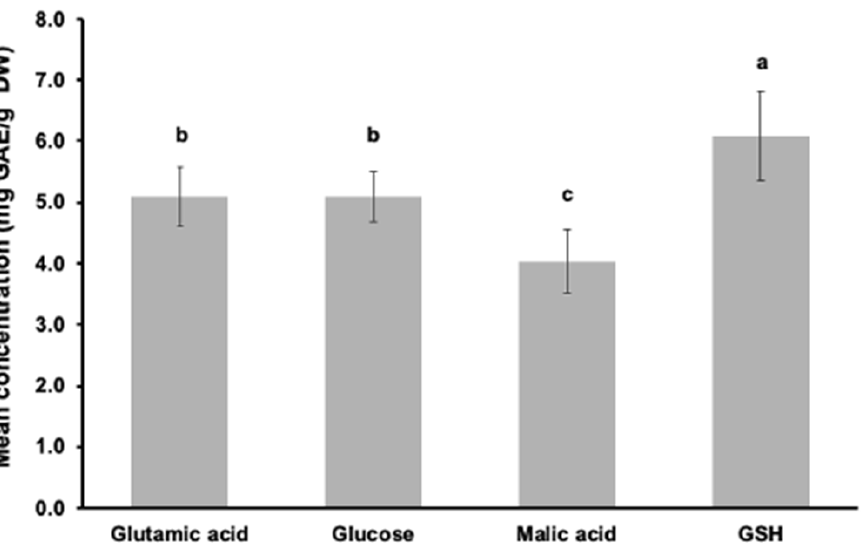
Figure 2. Mean reducing compound concentrations measured in the amended cultures (glutamic acid, glucose, malic and GSH) over the log phase. Different superscript letters indicate significant differences ( p < 0.05) as determined by Wilcoxon test.